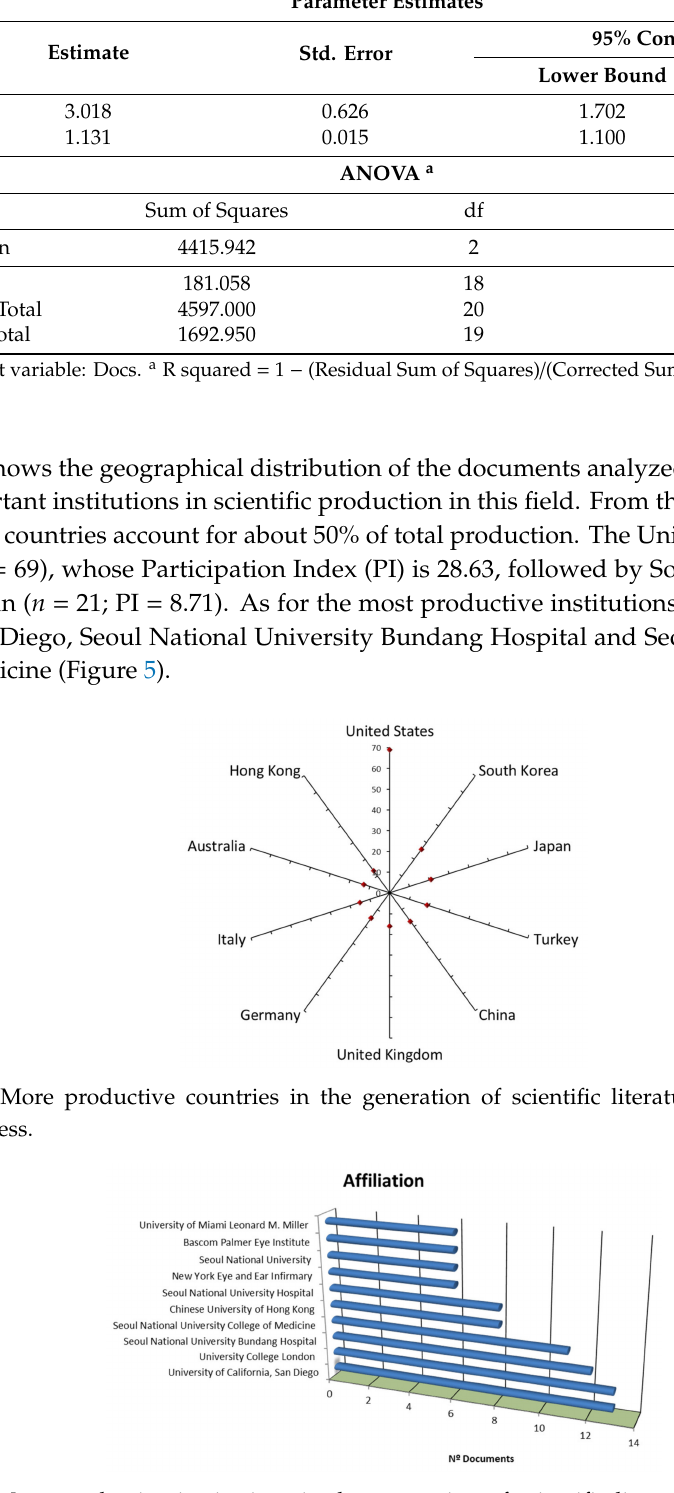
Figure 5. More productive institutions in the generation of scientific literature on retinal nerve fiber